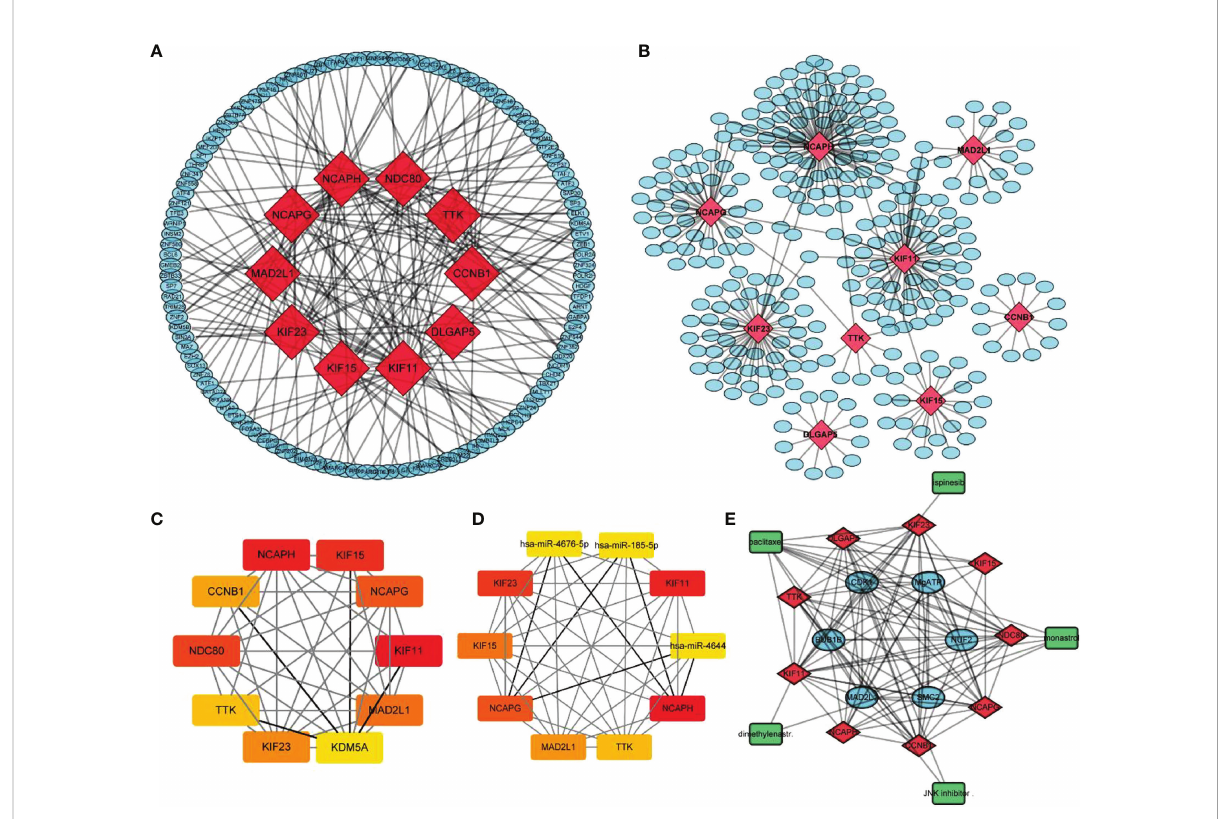
FIGURE 8 Analysis of core molecule interaction network. (A) TF-mrna regulatory network, red square represents hub gene, blue circle represents upstream transcription factors; (B) mirNA-mrna regulatory network, red square represents hub gene, blue circle represents its upstream miRNA; (C) TF-mrna regulatory network hub molecule; (D) Hub molecule of mirNA-mrna regulatory network; (E) Drug small molecule-mrna regulatory network, blue circle represents the protein interacting with Hub gene, red diamond represents Hub gene, green square represents the drug small molecule interacting with hub